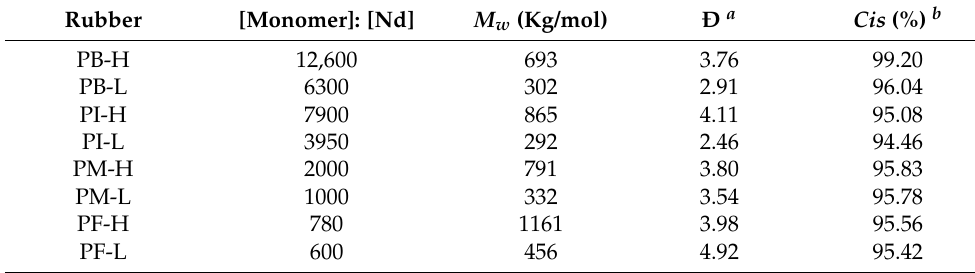
Table 2. Macro- and microstructural properties of synthesized